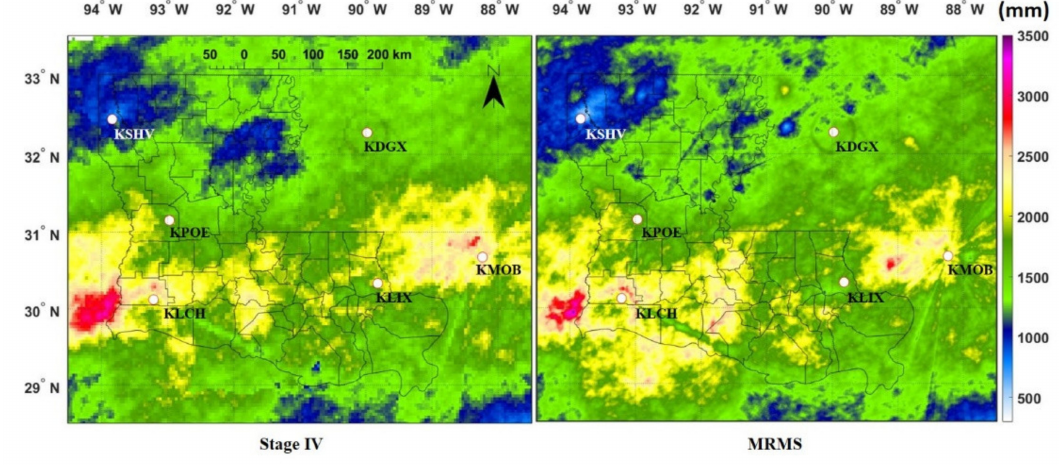
Figure 4. Spatial rainfall accumulation maps in millimeters of Stage IV (left) and Multi-Radar Multi-(MRMS), (right), for the year